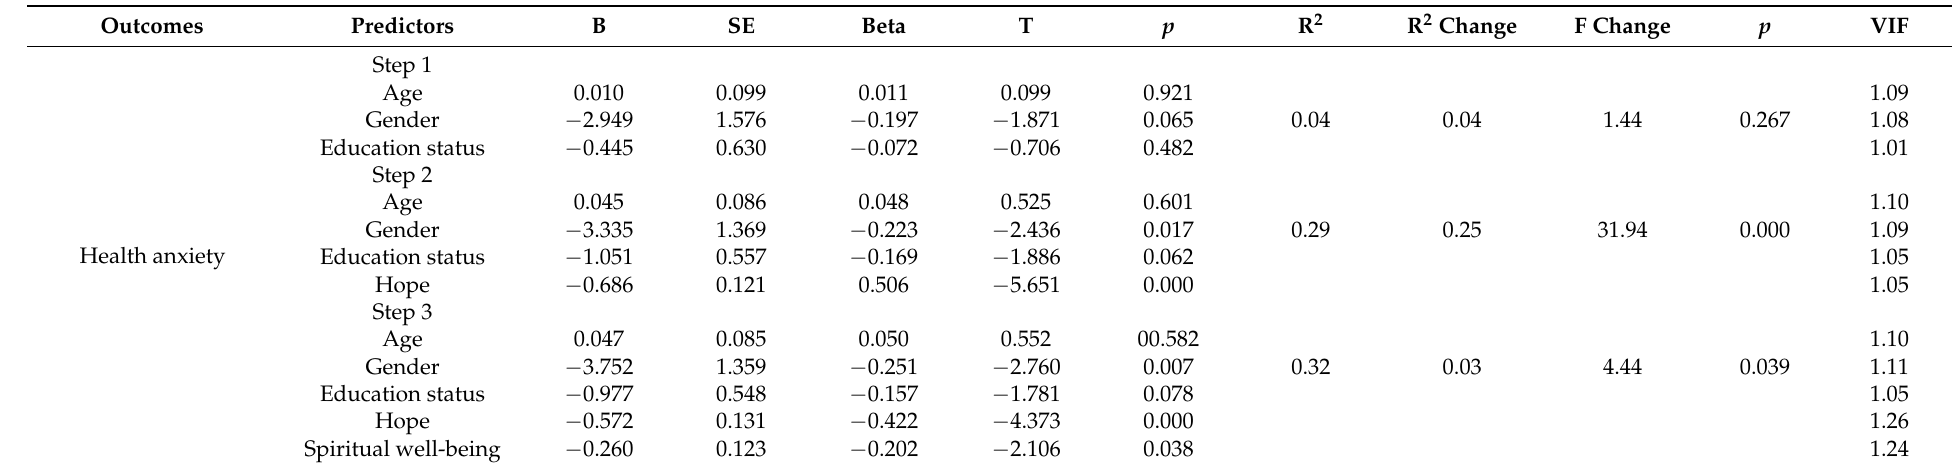
Table 3. Results of hierarchical multiple regressions for total scores of hope and spiritual well-being as predictors of health